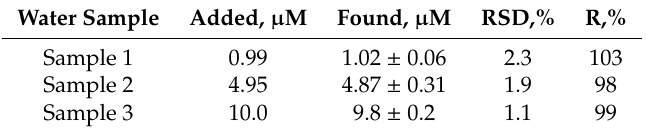
Table 5. Determination of NO 2 − in water samples, using the TrX100 / FCVE ( n = 3, p = 0.95).